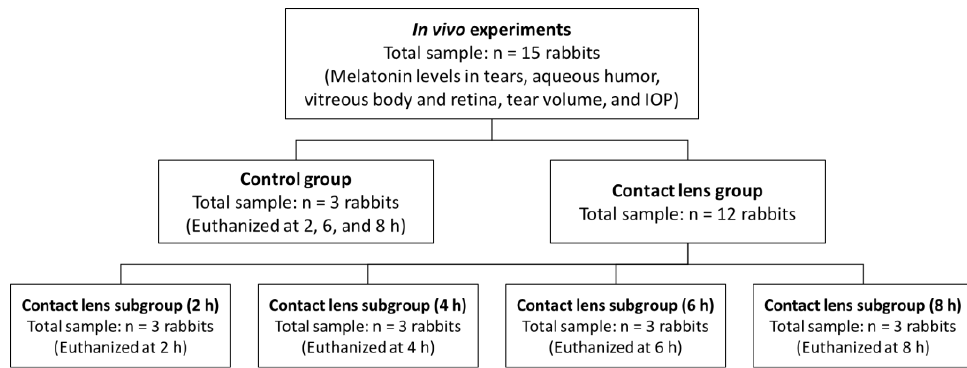
Figure 1. Distribution of the rabbits in the in vivo experiments.